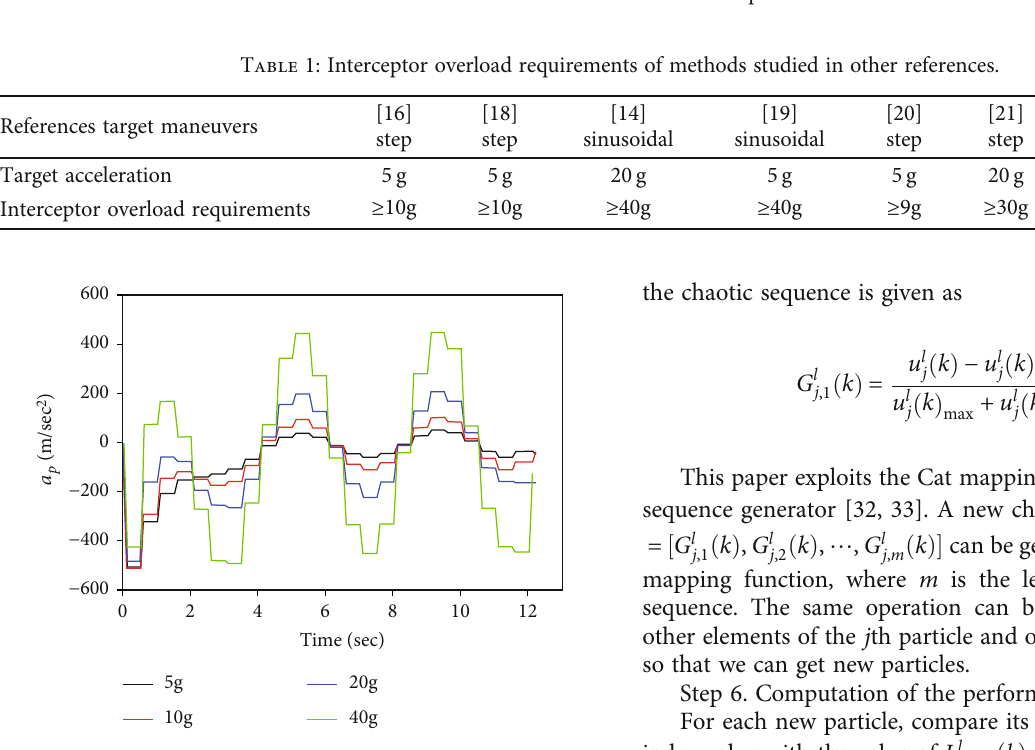
Figure 7: Lateral acceleration of the